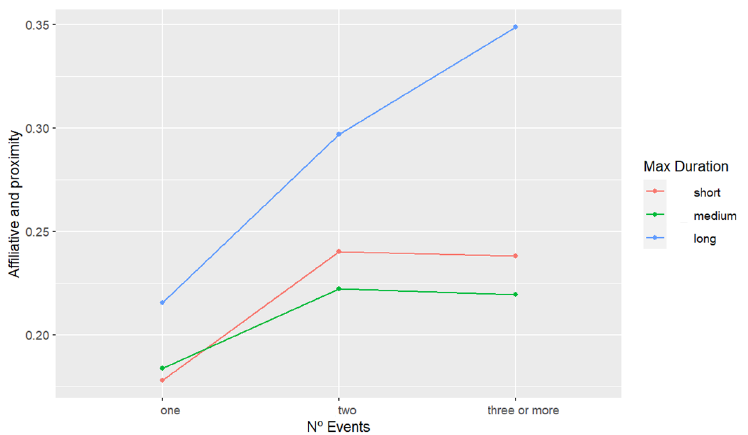
Figure 6. Plot representing the effect of the interaction between N° events and max duration on daytime affiliative and proximity behaviors of the chimpanzees. Each point on the plot is a predicted mean “Social proximity & Affiliative behavior” value and each connection between two points describes the effect, based on the data of the “Social proximity & Affiliative behavior” LMM model with N° events, max duration, sex, age category, and the interaction of N° events, max duration as fixed factors.